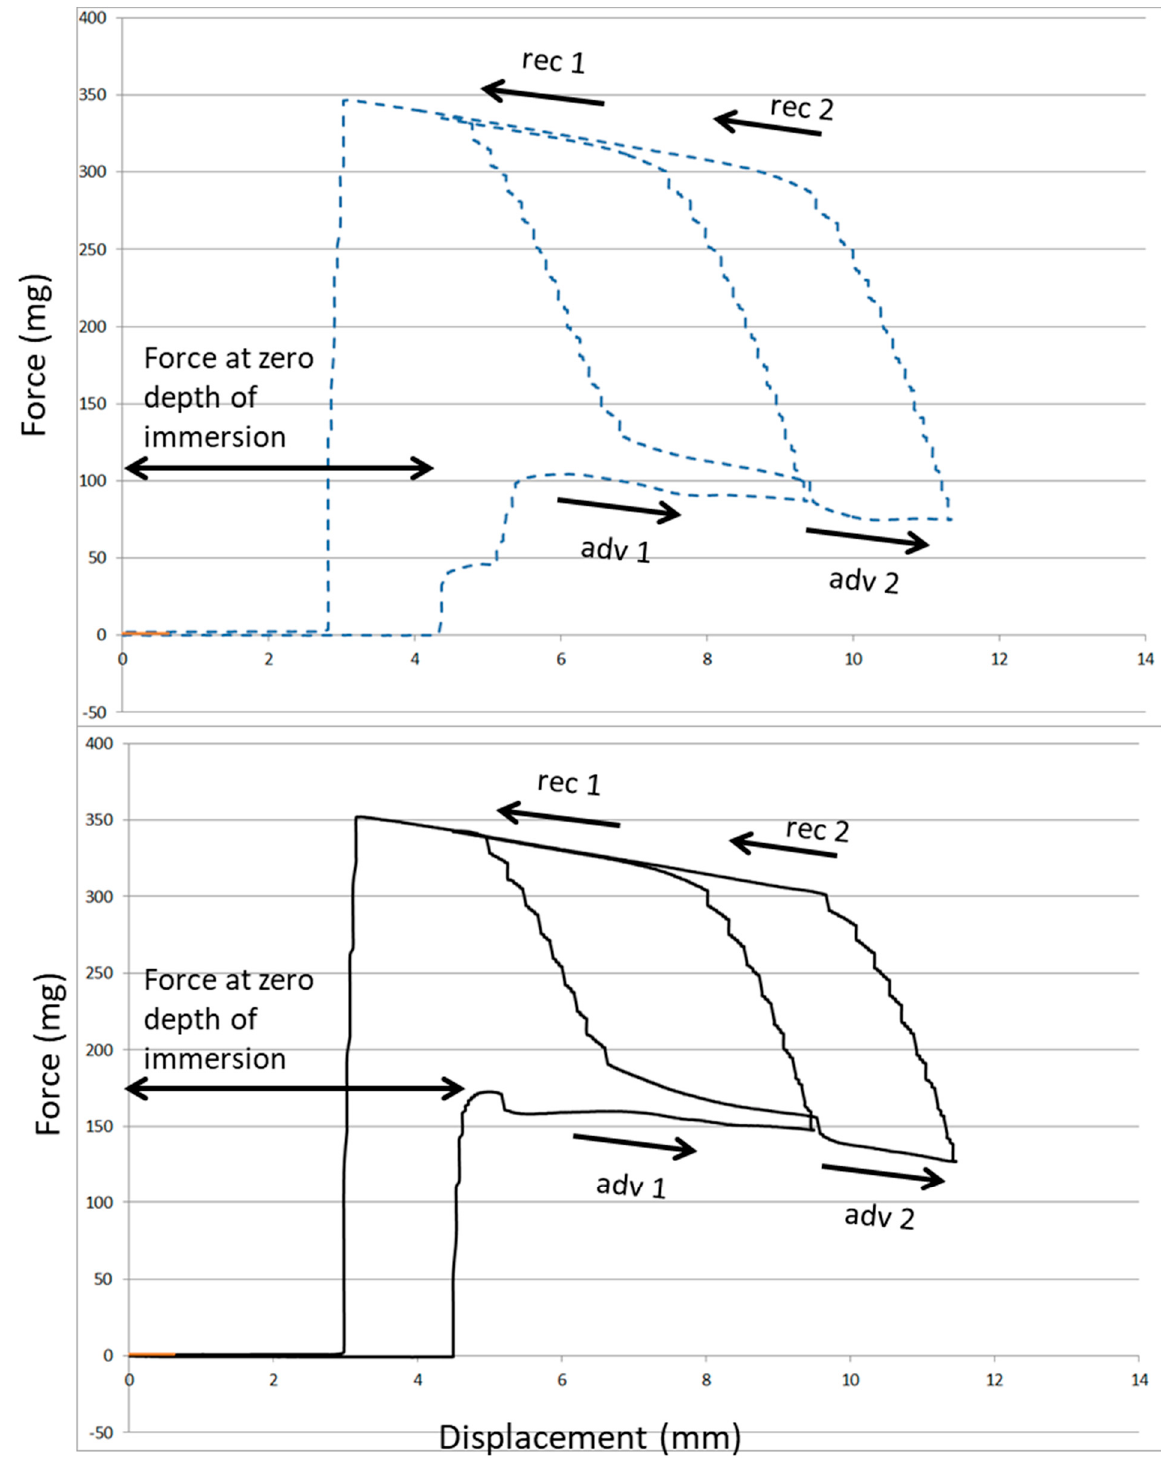
Figure 7. Wetting loops obtained by Wilhelmy plate measurements on Ti-PDA-EGCg (top) and Ti-PDA-aPEG-EGCg (bottom). Note the significantly higher (~50%) increase of the capillary force exerted by water on Ti-PDA-aPEG-EGCg, as indicated by the force at zero depth of immersion (ZOI). adv 1 = advancing portion of the first wetting loop; adv 2 = advancing portion of the second wetting loop; rec 1 = receding portion of the first wetting loop; rec 2 = receding portion of the second wetting loop.